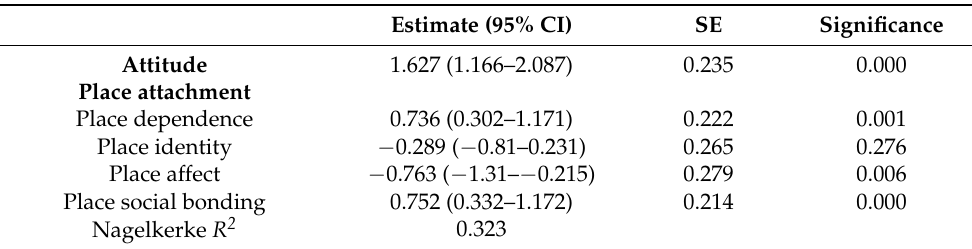
Table 4. Ordinal regression analysis of the relationship between willingness to pay with attitude and place attachment (n =